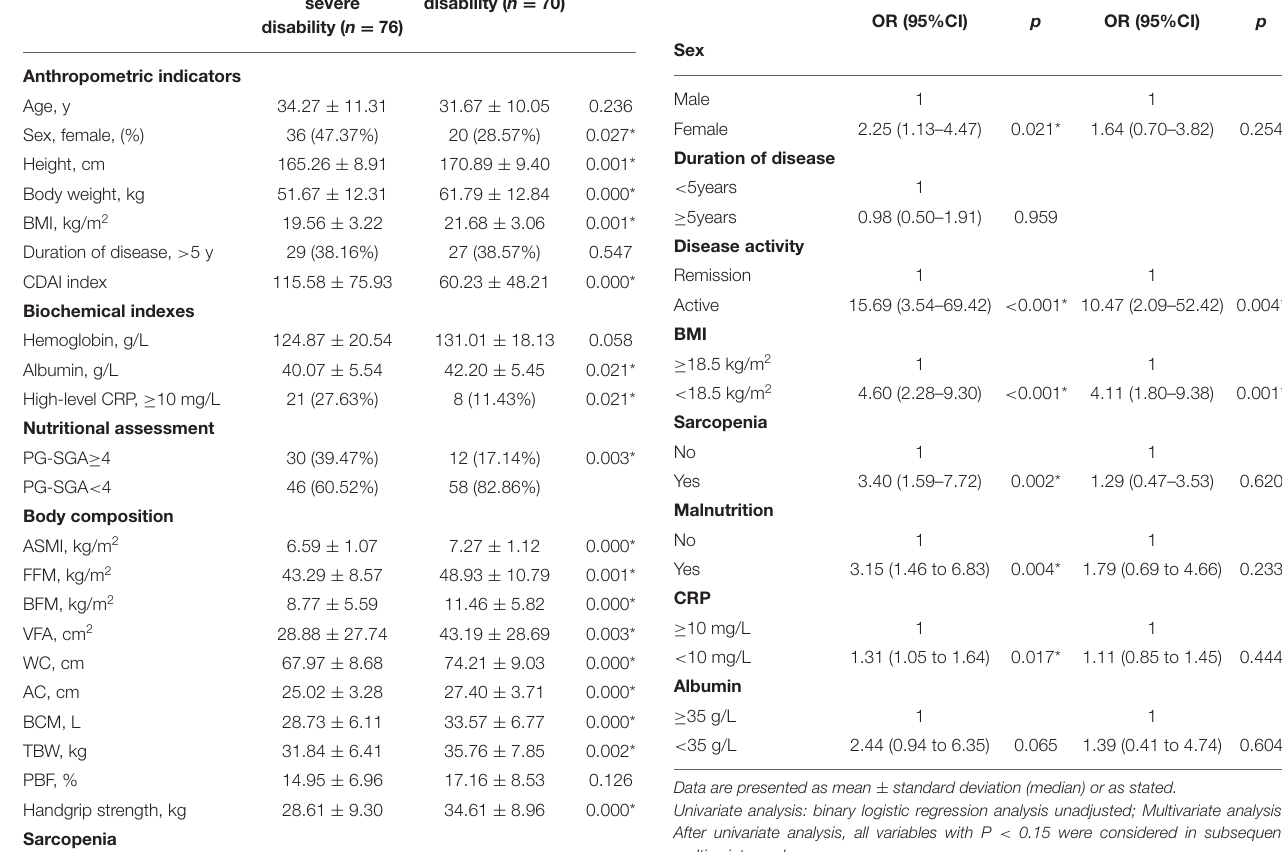
TABLE 3 | General characteristics of CD patients with moderate to severe disability vs. Without to minimal disability. Moderate to severe